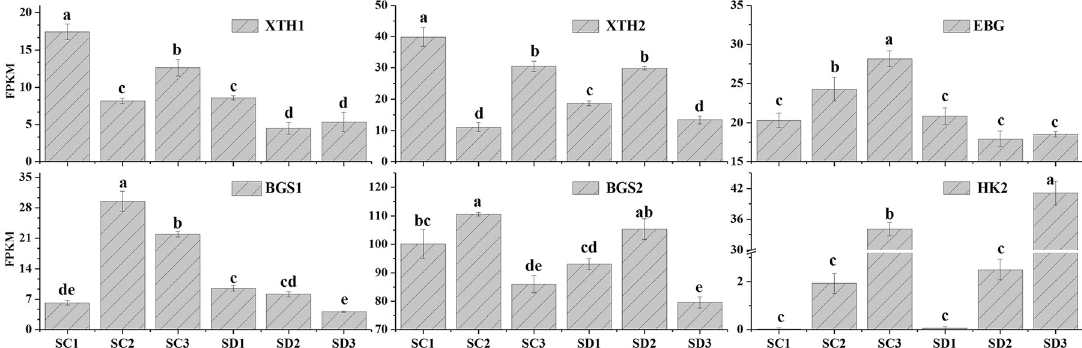
Fig 8. Expression analyses of genes related to cellulose degradation. The x-axis indicates the different stages. The y-axis shows the expression values of the FPKMs. All values were repeated three times and the data are presented as the mean ± SD. Different letters indicate significant differences at P < 0.01. XTH1: CU_locus1414; XTH2: CU_locus1411; EBG: CU_locus7296; BGS1: CU_locus37299; BGS2: CU_locus24729; HK2: